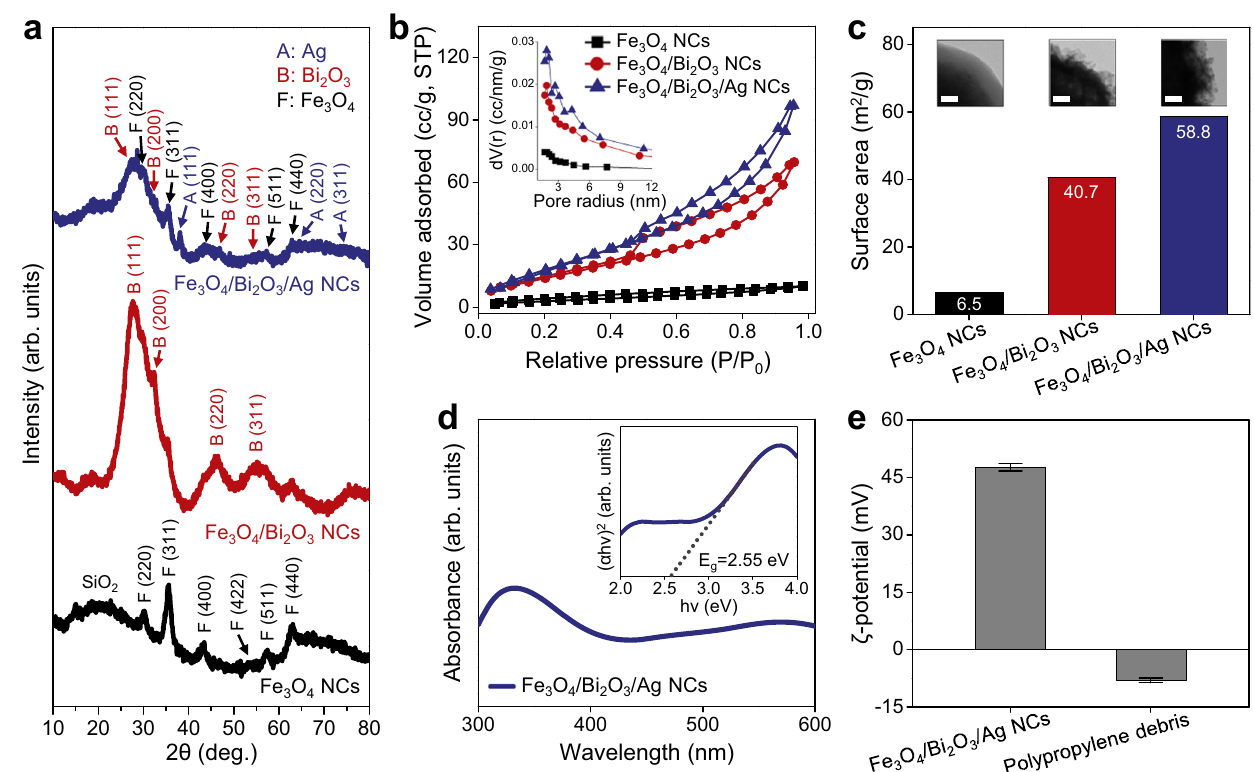
Fig. 3 | Compositional, surface, and optical properties of 1D magnetic photo- active microrobots. a XRD patterns of the Fe 3 O 4 NCs (black), Fe 3 O 4 /Bi 2 O 3 NCs (red),andFe 3 O 4 /Bi 2 O 3 /AgNCs(blue). b , c N 2 adsorption – desorptionisotherms( b ), pore size distribution (inset), and comparison of surface area ( c ) for Fe 3 O 4 NCs (black), Fe 3 O 4 /Bi 2 O 3 NCs (red), and Fe 3 O 4 /Bi 2 O 3 /Ag NCs (blue). The inset TEM